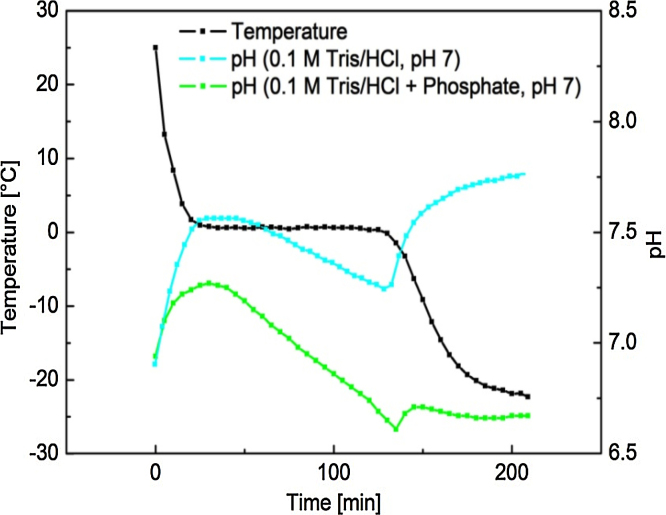
pH-shift and temperature in the centre of the freezing container during freezing of both 1 L 0.1 M Tris/HCl and 1 L 0.1 M Tris/HCl plus 15.7 mM phosphate at −30 ̊C plotted as a function of process time.